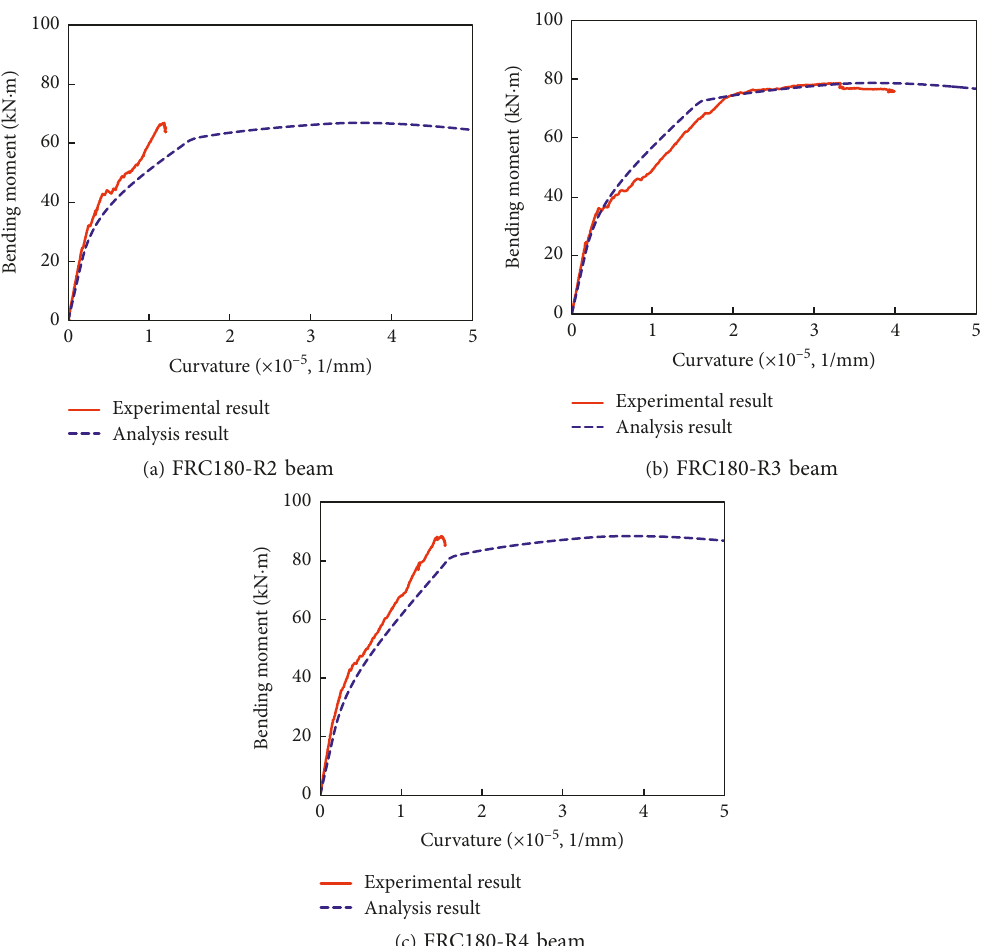
Figure 17: Fitting of moment-curvature curves between the experimental and analysis results (FRC180 series cracks within the constant moment region caused the bridging effect to weaken, and steel fibers were eventually pulled out of the matrix in the region of localized cracking.